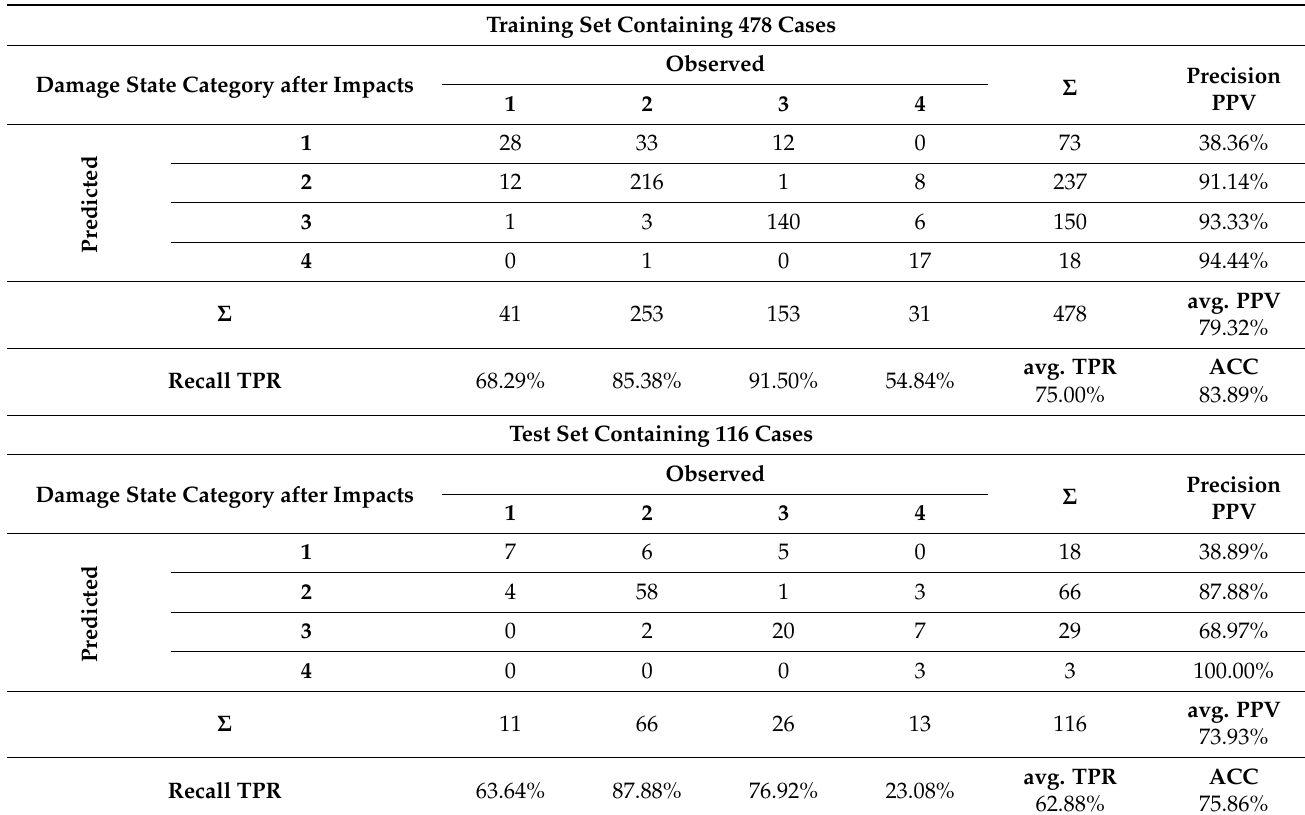
Table 5. Confusion matrix for the NBC classifier—accuracy of classification, average precision and average recall for training and test